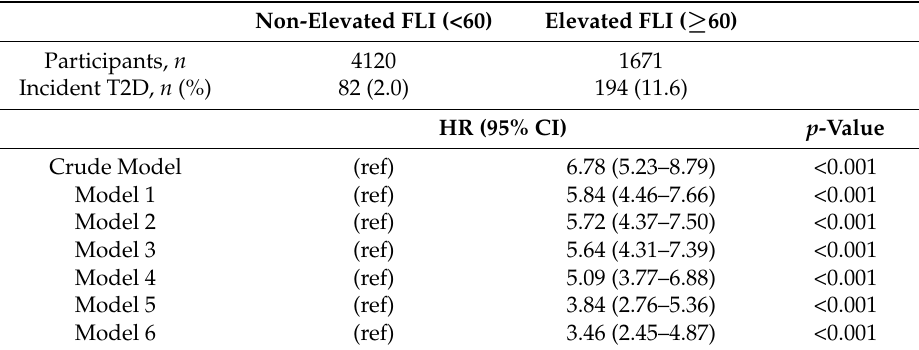
Table 3. Prospective associations of FLI with incident type 2 diabetes.